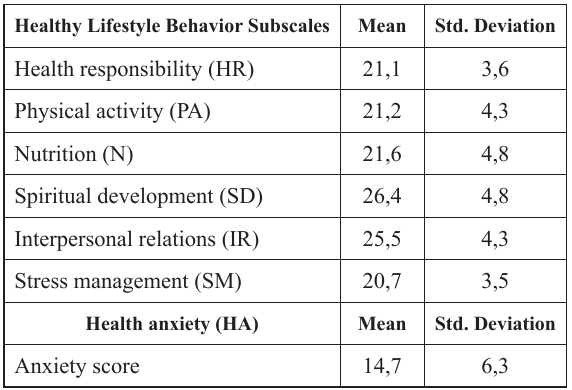
Table 3. Findings about scale results